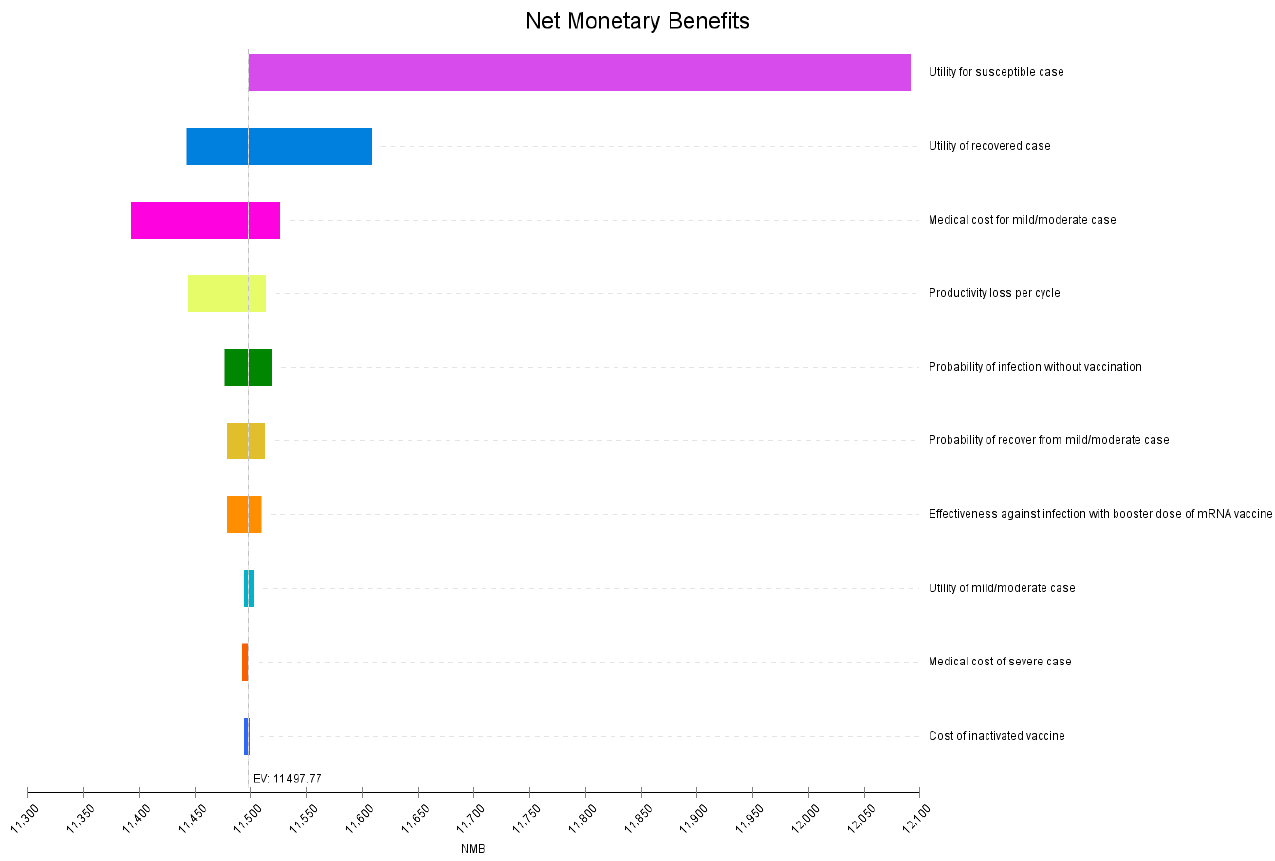
Figure 2. One-way sensitivity analyses of net monetary benefit for the model on willingness to pay.